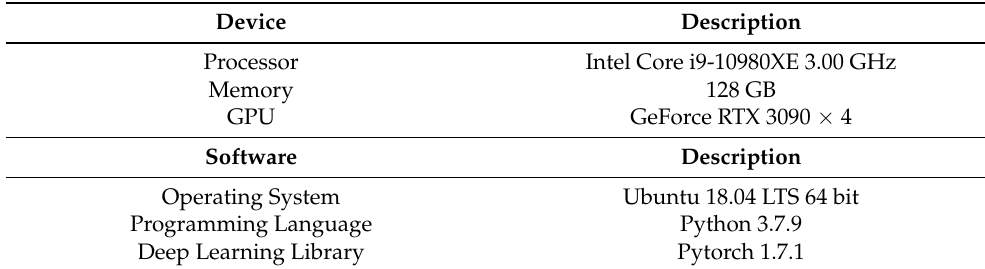
Table 1. Description of hardware/software